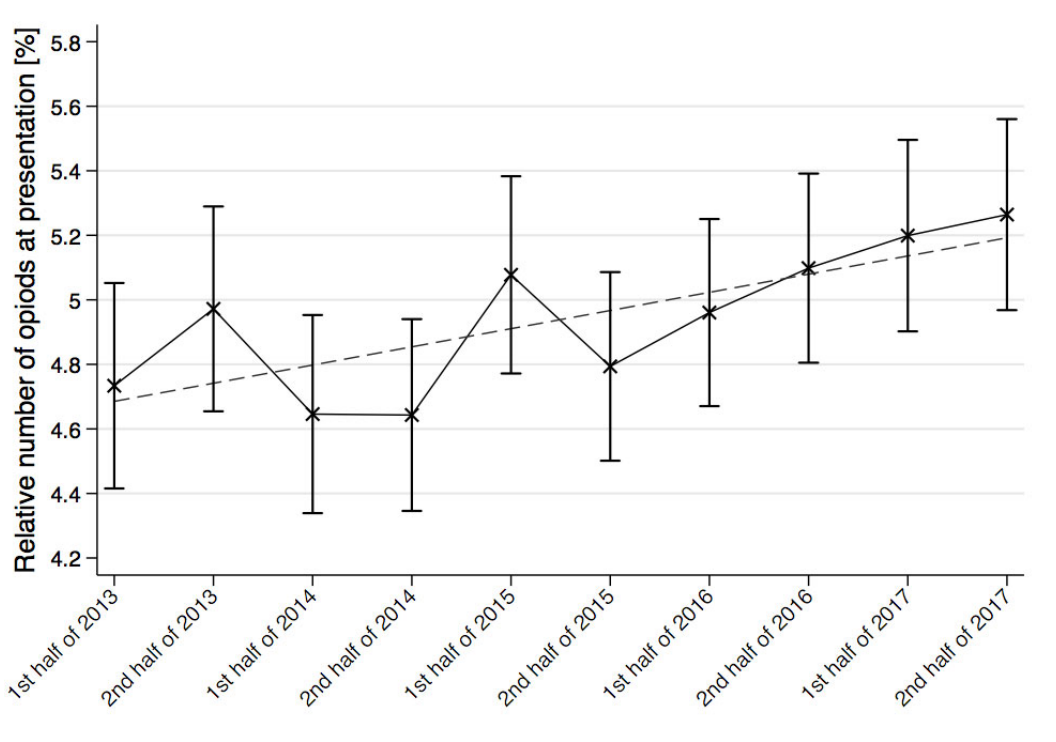
Figure S2: Prevalent opioid use at presentation. The relative number per 6 months with accompanying 95% confidence interval and linear trend are presented, n = 199,299. The chi-square test for trend showed a significant increase over time (p